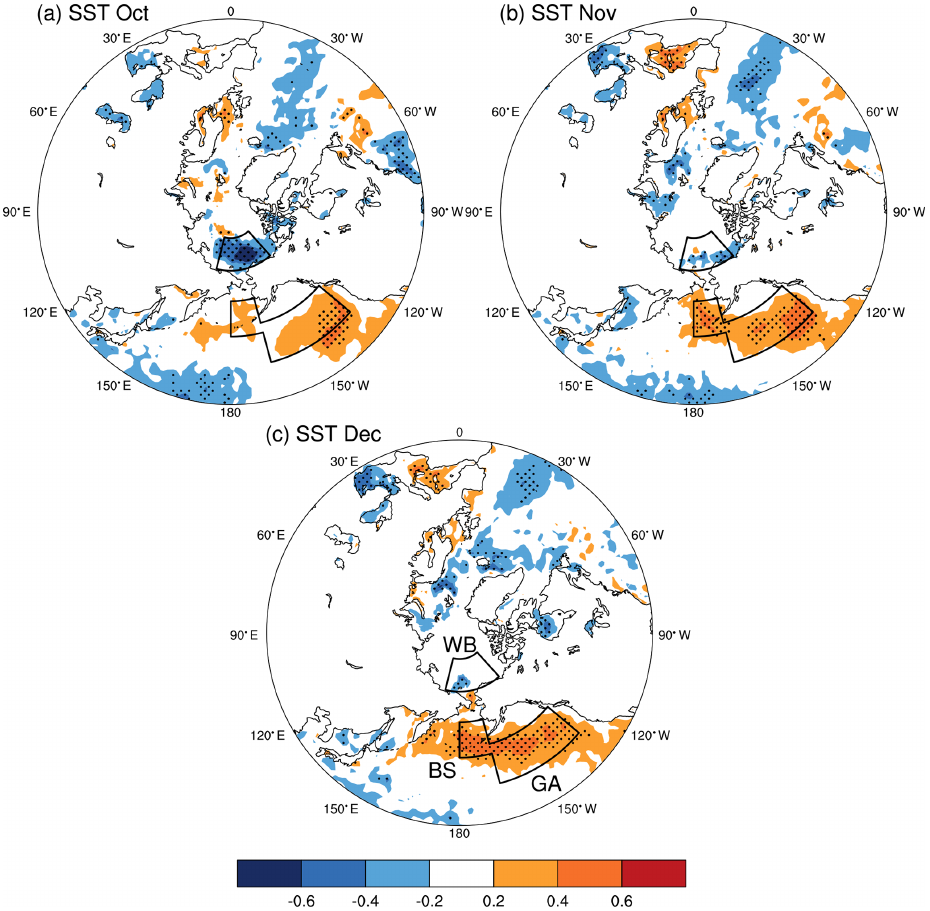
Figure 5. The CC between the BSISO and SST in (a) October, (b) November and (c) December from 1979 to 2015, after detrending. The black dots indicate CCs exceeding the 95% confidence level ( t test). The black boxes (WB: west of Beaufort Sea, BS: Bering Sea and GA: Gulf of Alaska) are the significantly correlated areas, which were used to calculate the SST